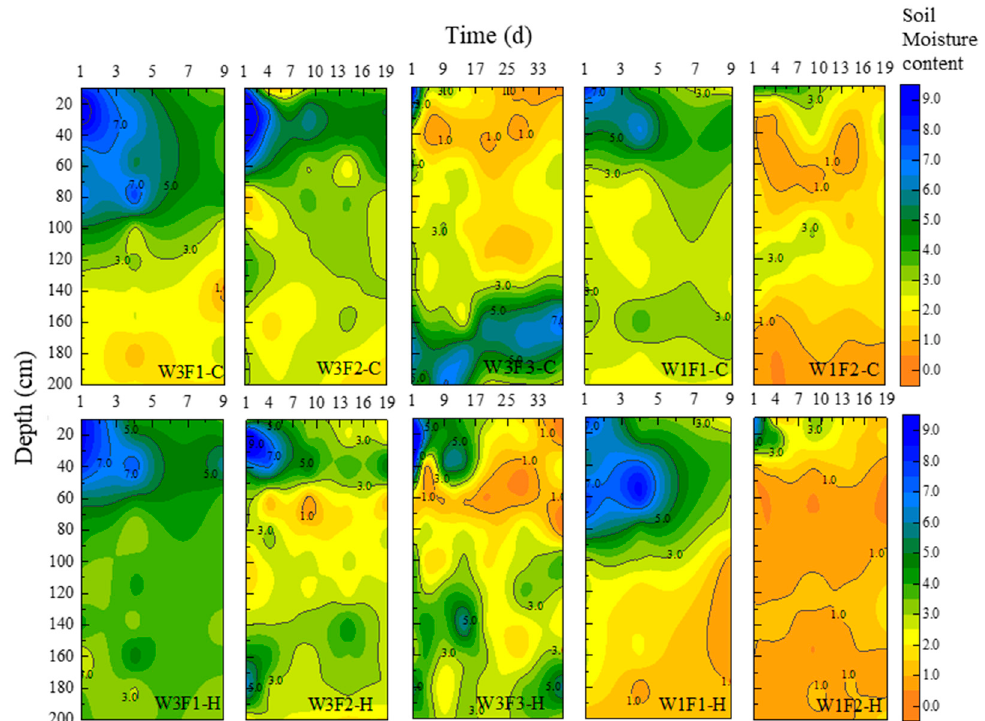
Figure 5. Temporal variation in soil moisture content in different treatments. The soil moisture content in the low (W1), medium (W2), and high (W3) irrigation amounts. F means irrigation frequency with F1 = 10 d, F2 = 20 d, F3 = 40 d. C and H represent C. mongolicum and H. ammodendron , respectively.